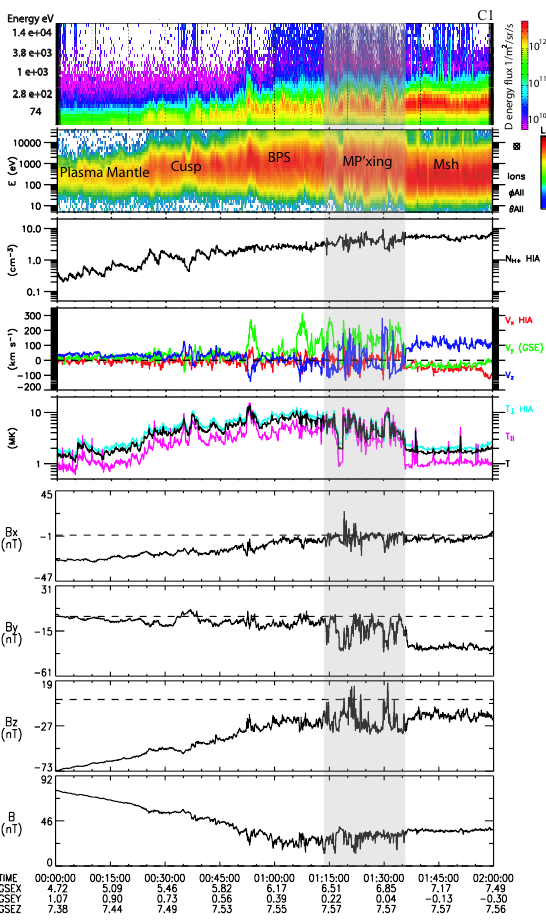
Fig. 5. The overview of the boundary crossings with large magnetic shear. Figure 5 has the same format as Fig.